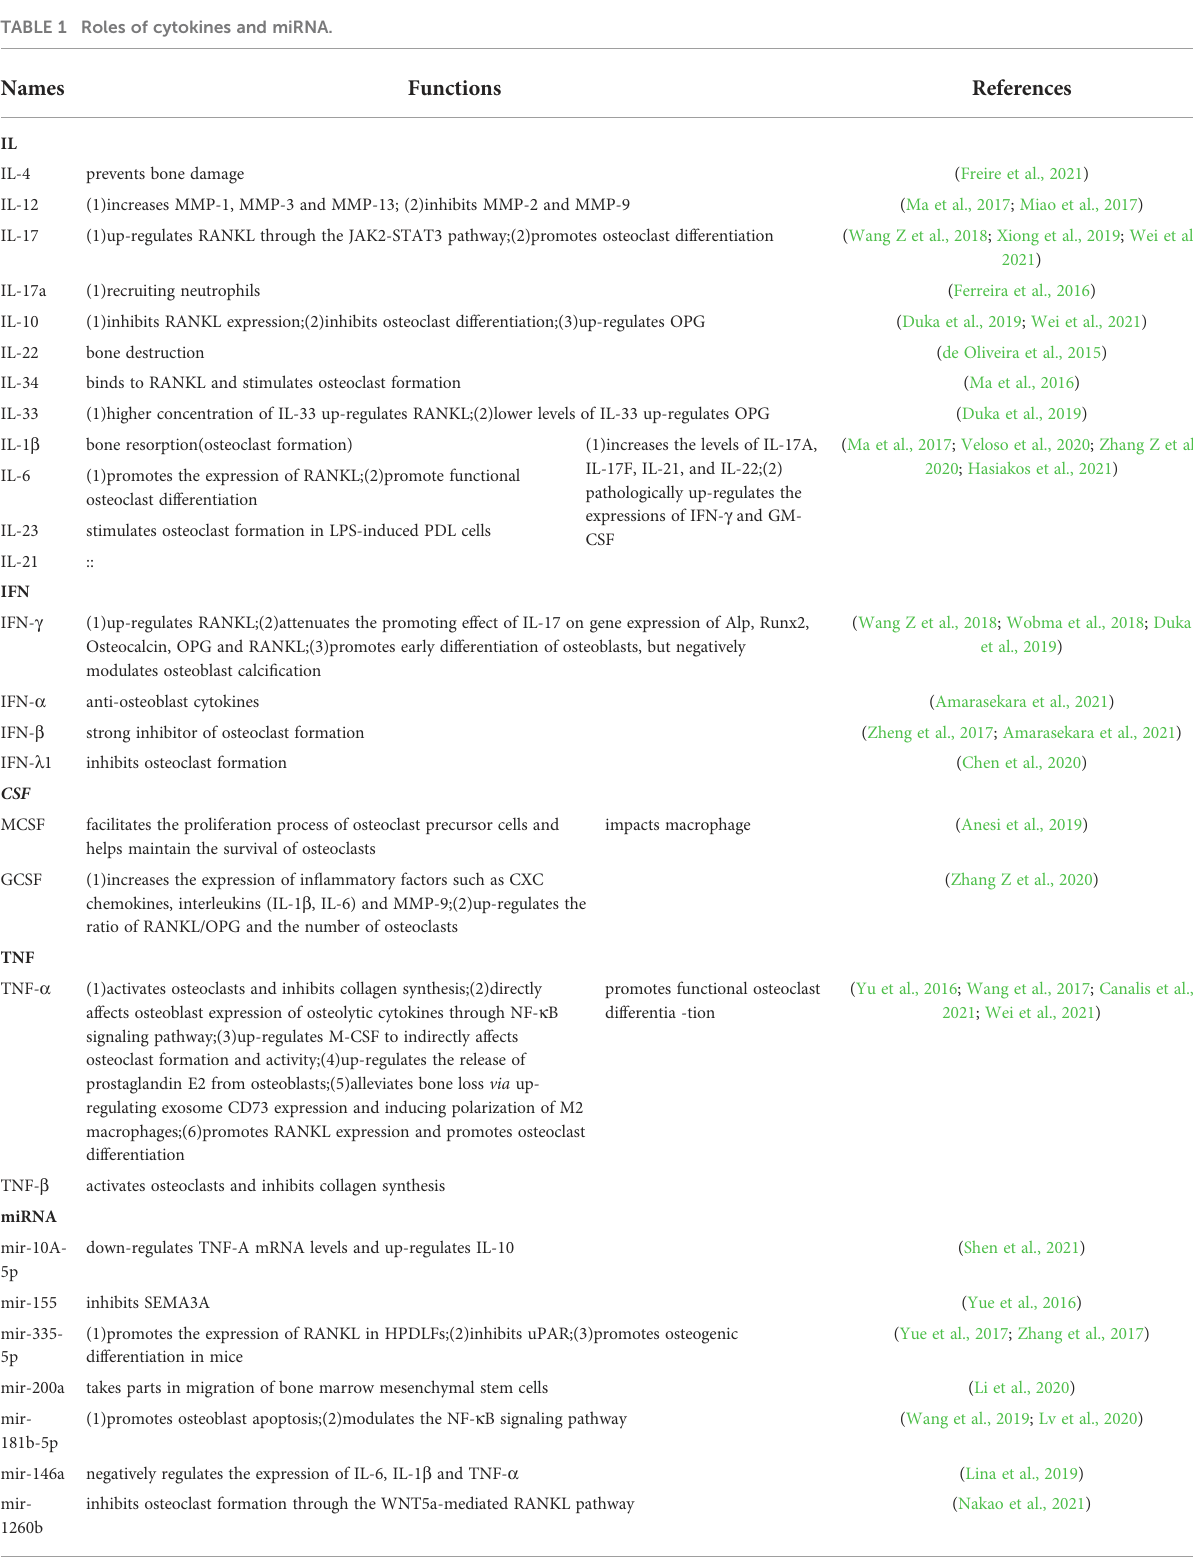
TABLE 1 Roles of cytokines and